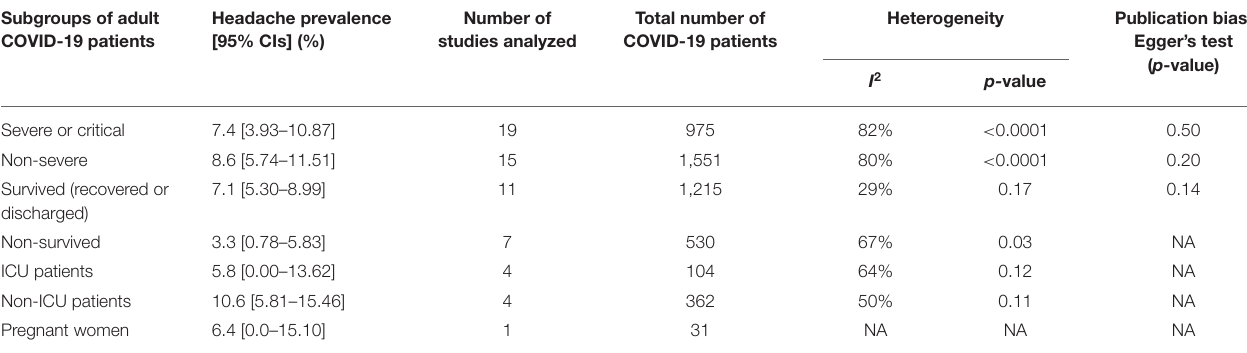
TABLE 2 | Pooled prevalence of headache in different subgroups of adult COVID-19 patients. Subgroups of adult COVID-19